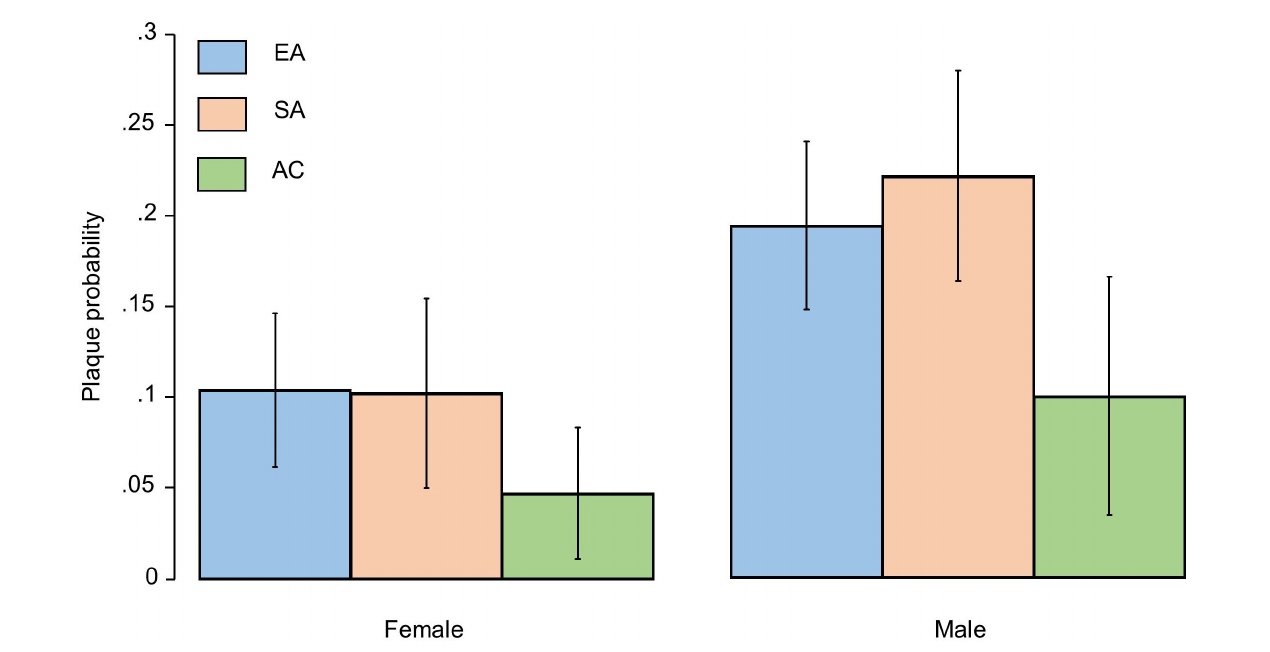
FIGURE2 Bar plot showing marginal probabilities with 95% confidence intervals (adjusted for age) of having a plaque by sex and ethnicity. EA, European; SA, South Asian, and AC, African Caribbean.